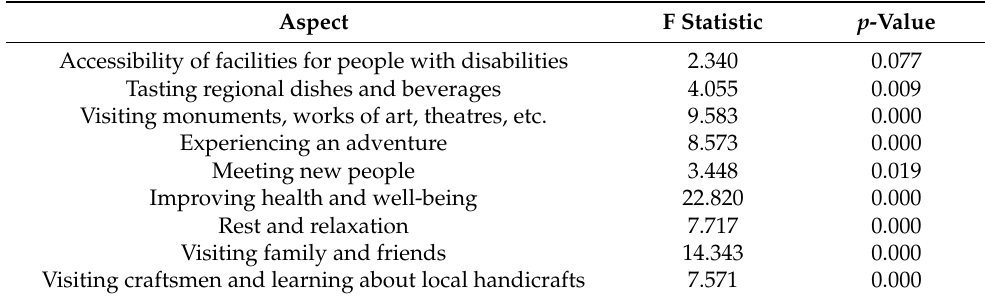
Table 9. Results of ANOVA for the importance of aspects of the trips with respect to country.